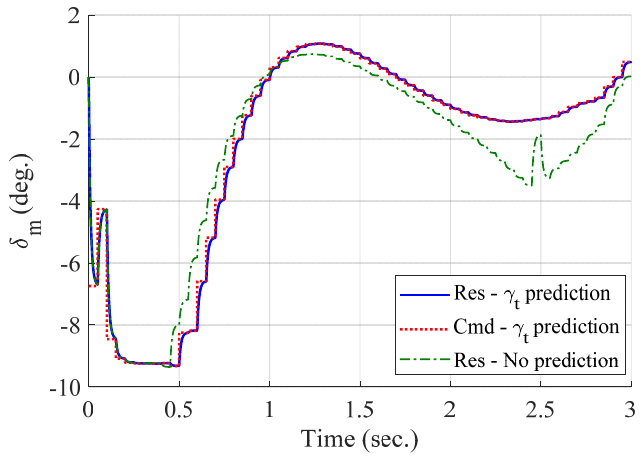
Figure 5. Control input of the missile (single-run simulation).